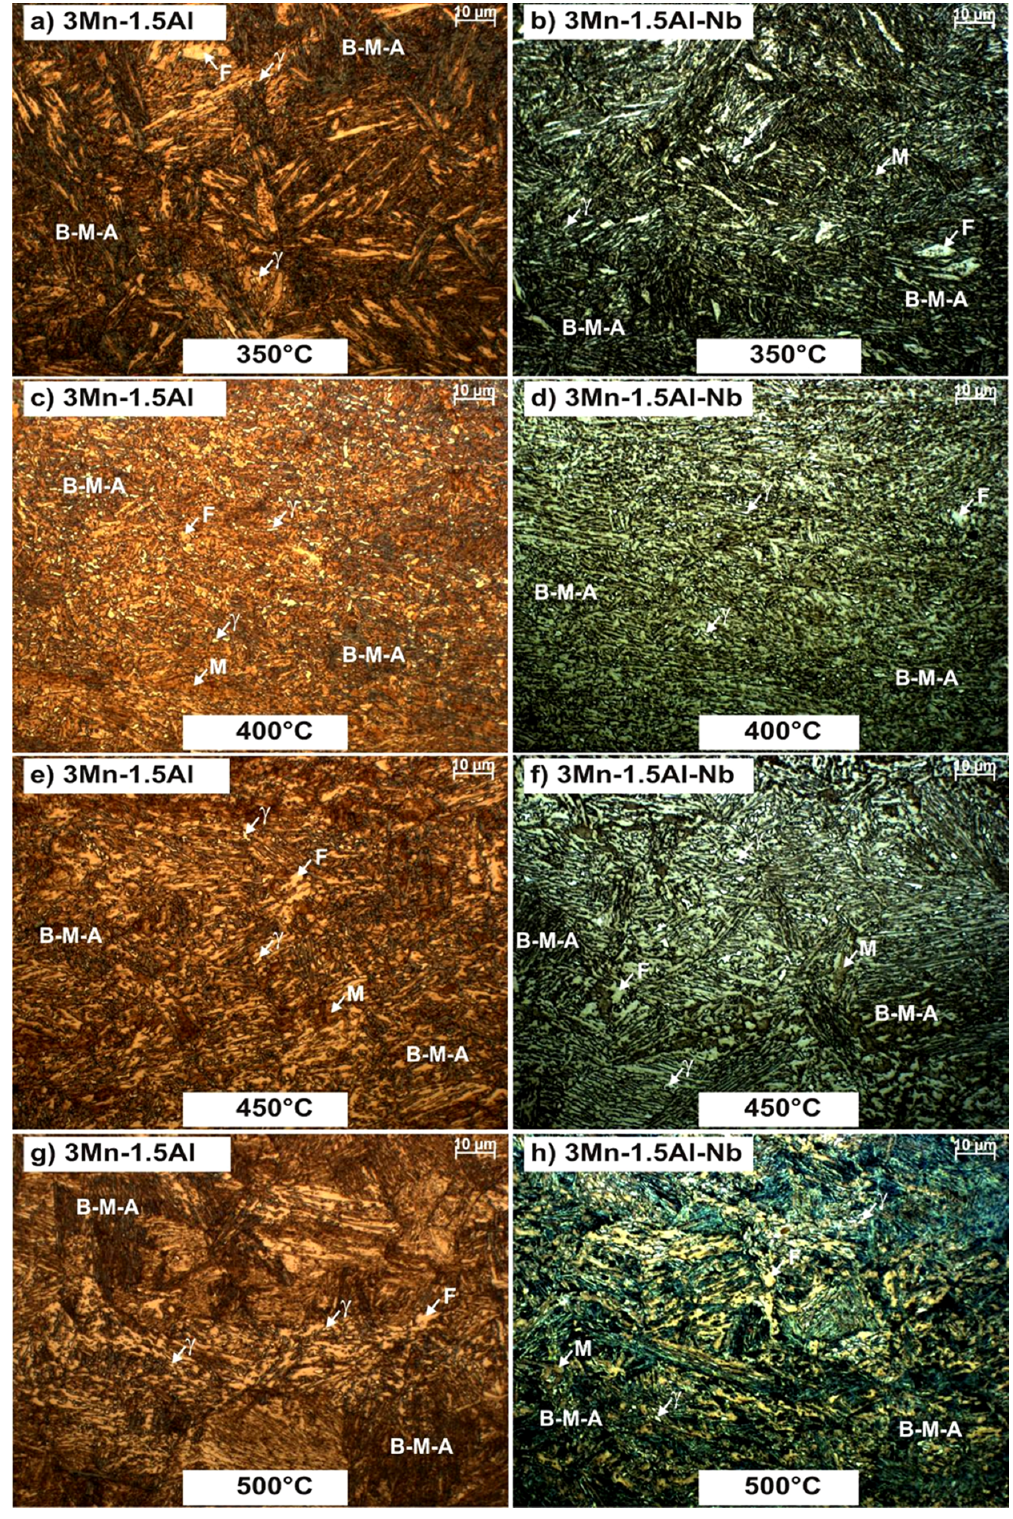
Figure 7. Multiphase microstructures of 3Mn and 3MnNb steels isothermally held at: ( a ) and ( b ) 350 °C, ( c ) and ( d ) 400 °C, ( e ) and ( f ) 450 °C, ( g ) and ( h ) 500 °C, for 300 s (LM).